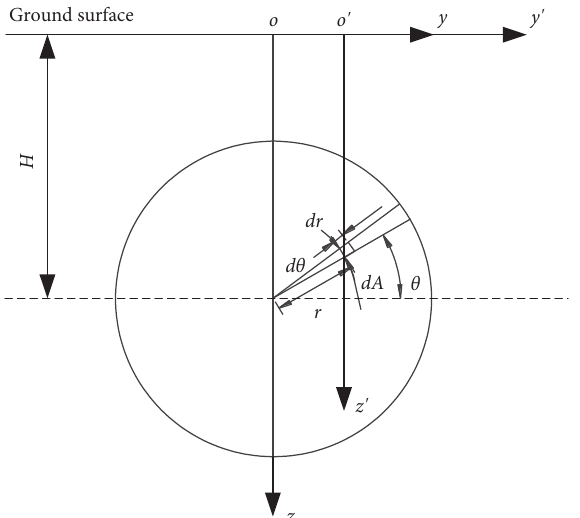
Figure 2: Integral diagram of the additional thrust on the front of the shield machine.